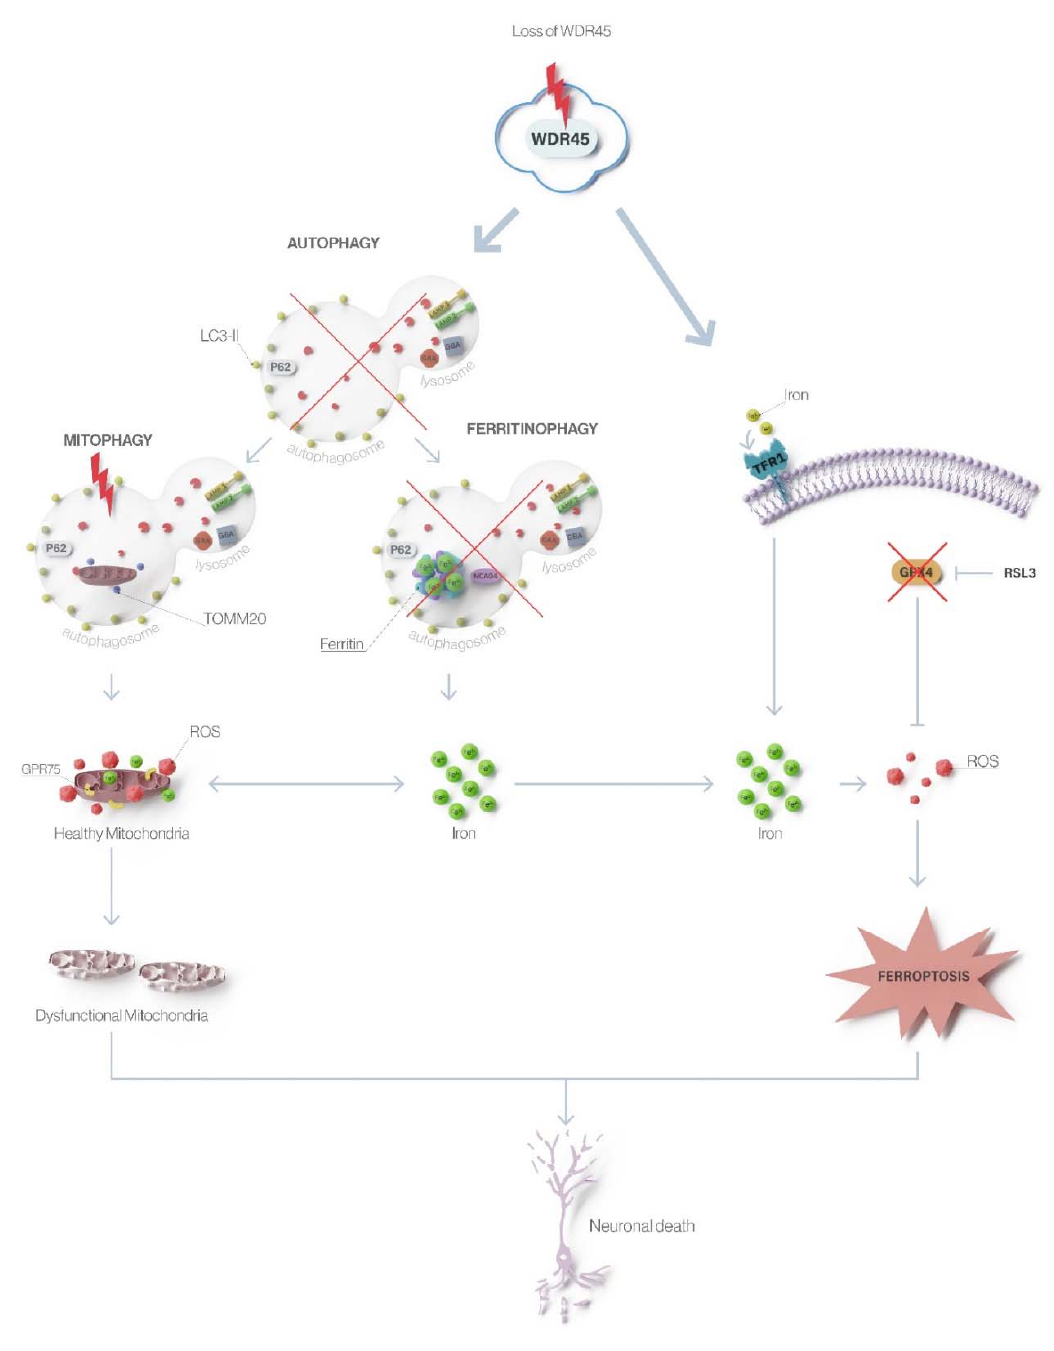
Figure 6. Loss of WDR45 leads to altered autophagy, ferritinophagy, and ferroptosis in β -propeller protein-associated neurodegeneration. Mutations in WDR45 cause impaired autophagy as the primary defect that further leads to disturbed degradation of iron-rich ferritin (affecting ferritinophagy) and iron-containing organelles like mitochondria (affecting mitophagy). Lack of ferritinophagy leads to increased total cellular iron levels, which, through ROS formation and oxidative stress, triggers ferroptosis resulting in neuronal death.